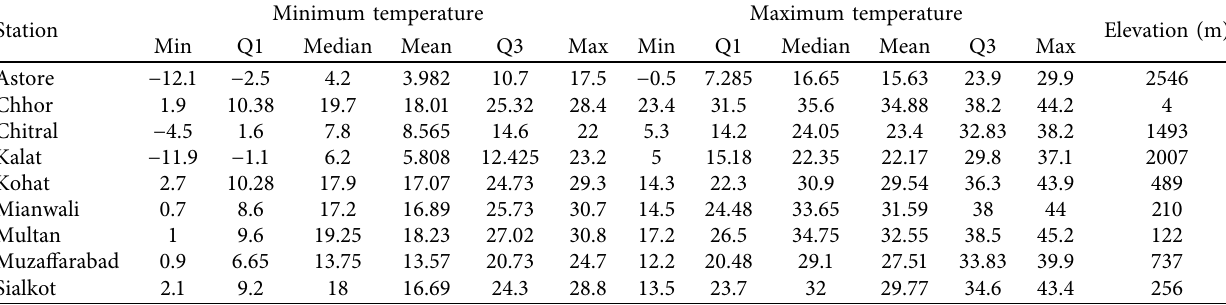
Minimum temperature